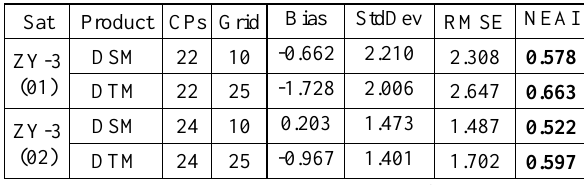
Table 5. The DSM and DTM accuracy of the ZY-3 twin satellites (unit: meter) 4. COMPARISON AND ANALYSIS The bundle adjustment accuracy and DEM extraction accuracy from the twin satellites stereoscopic image data is satisfactory. In order to further analyze the accuracy of the ZY-3 satellites, the horizontal and vertical accuracy of the twin DEM products are evaluated and compared. In addition, accuracy comparisons are performed with the SRTM DEM data. 4.1 DSM Comparison of the twin satellites Difference between the digital surface models with the grid spacing of 10m from the twin satellites has been computed. Horizontal registration error and height discrepancy are analyzed, the statistics are showed in Table 6 and the corresponding frequency distribution chart is described in Figure 4. The horizontal bias (table 6) is almost negligible since the twin DSMs production based on the same GCPs.